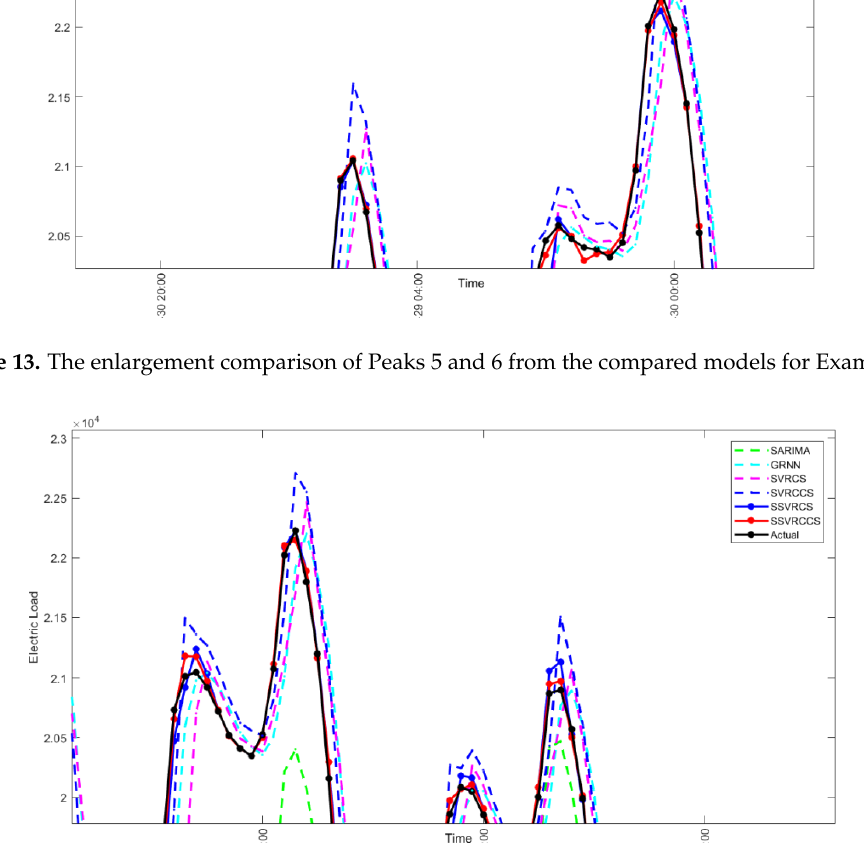
Figure 14. The enlargement comparison of Peaks 7 and 8 from the compared models for Example 2.